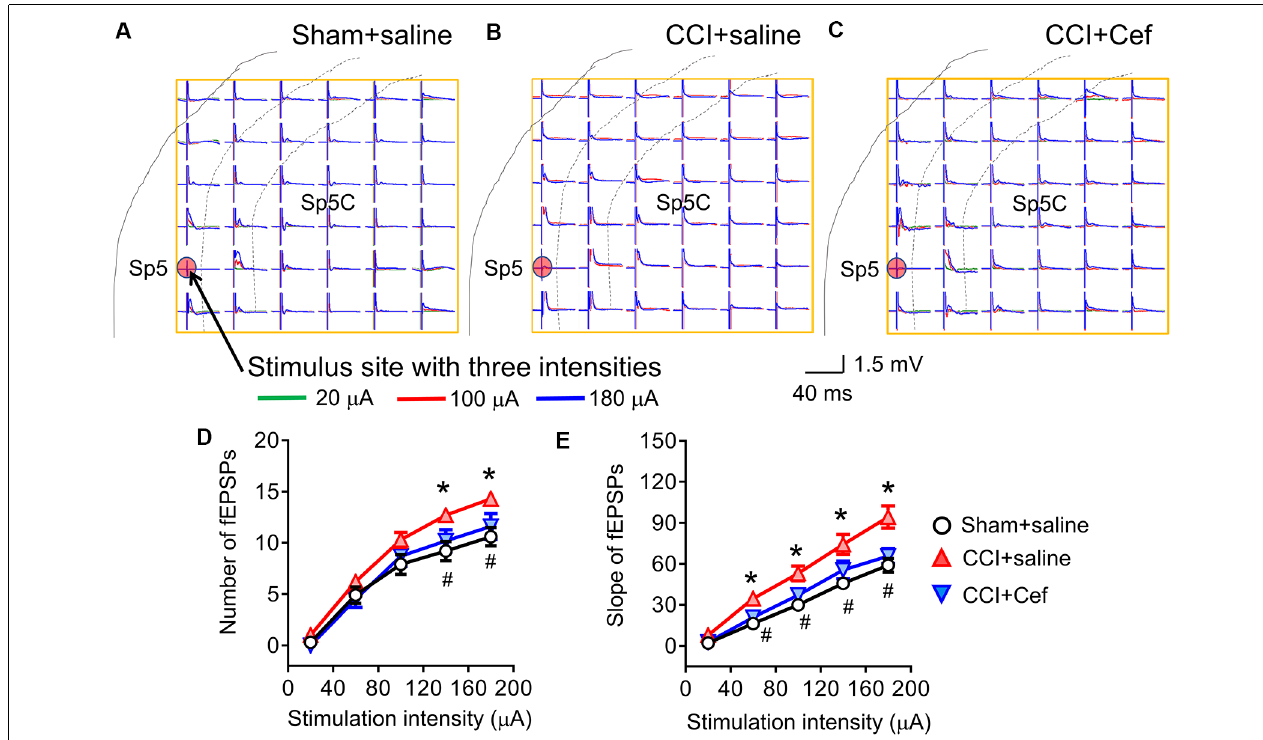
FIGURE 5 | Reversal effects of repeated systemic administration of ceftriaxone (Cef) on CCI-ION-induced enhancement of network field excitatory postsynaptic potentials (fEPSPs) response. Panels (A–C) shows typical examples of the MEA (8 × 8, 64 electrodes) recordings on a rat medullary dorsal horn (Sp5C) slice from Sham + saline, CCI + saline and CCI + Cef groups following three intensities (overlapping traces: green for 20 µ A, red for 100 µ A and blue for 180 µ A) of electrical stimulation at the Sp5 (red dot). Panel (D) shows the average number of evoked fEPSPs following electrical stimulation with a series of intensities ranging from 20 µ A to 199 µ A in Sham + saline ( n = 10), CCI + saline ( n = 10) and CCI-Cef ( n = 9) groups. Panel (E) shows averaged slope of evoked fEPSPs following electrical stimulation with a series of intensities ranging from 20 µ A to 199 µ A in Sham + saline ( n = 10), CCI + saline ( n = 10) and CCI-Cef ( n = 9) groups. The data of panels (D,E) are presented as mean ± SEM. * p < 0.05 , CCI + saline vs. Sham + saline; # p < 0.05 , CCI + Cef vs. CCI +